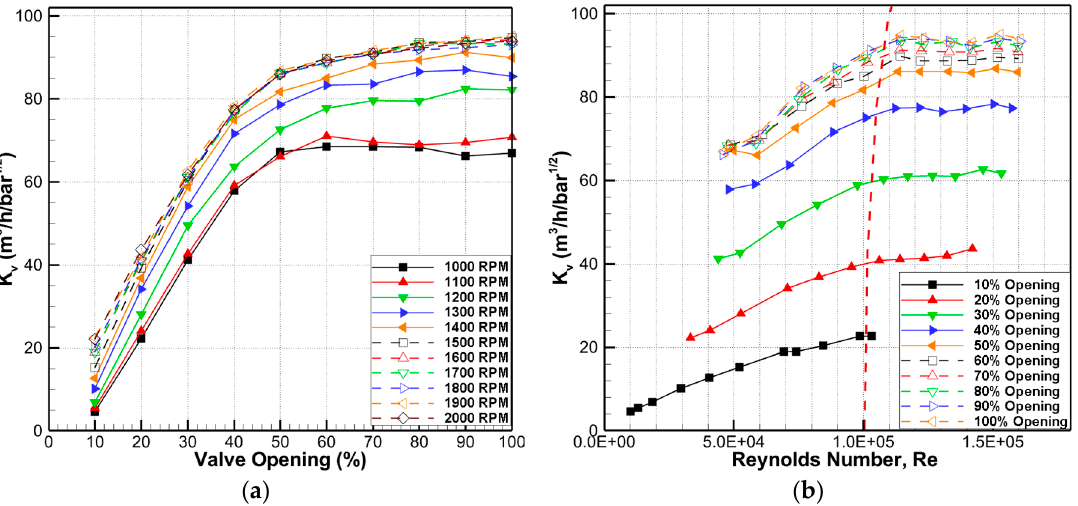
Figure 12. Flow coefficient in installed condition: ( a ) with respect to valve opening; ( b ) with respect to Renolds number.